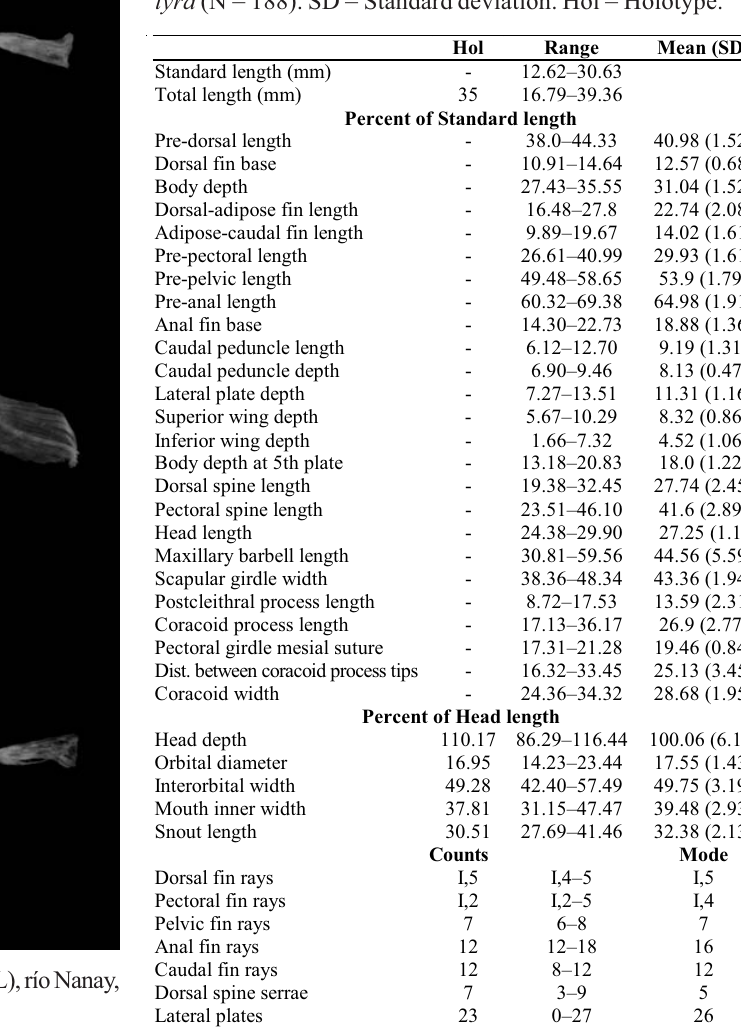
Table 1. Descriptive morphometrics and counts of